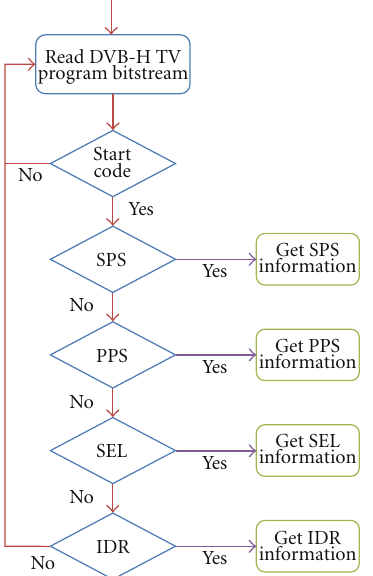
Figure 8: DVB-H TV Signal Reference Parse.